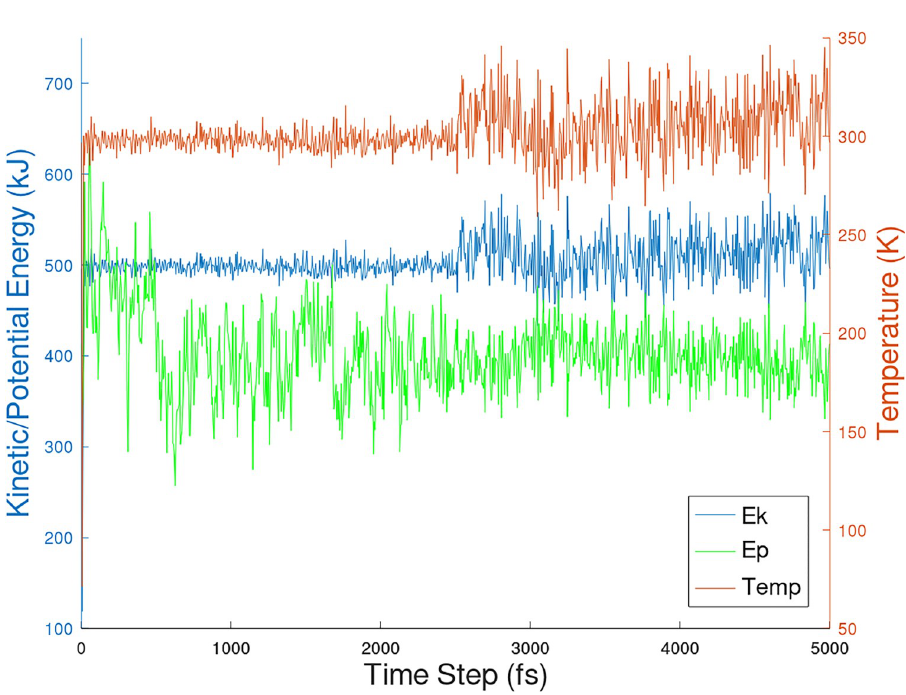
Fig 10. Kinetic, potential and temperature variations in molecular dynamics simulations of 1-POPC docked structure with RMSD = 0.